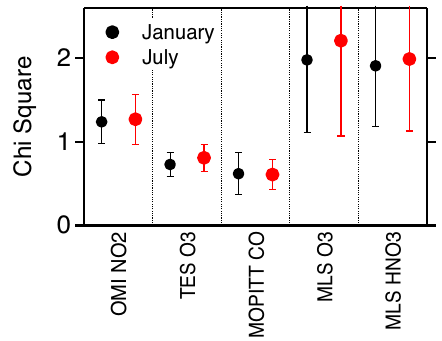
Fig. 6. χ 2 value (in vertical axis) estimated for each assimilated data set (in horizontal axis) averaged over the 10–30 January (black) and July (red) in